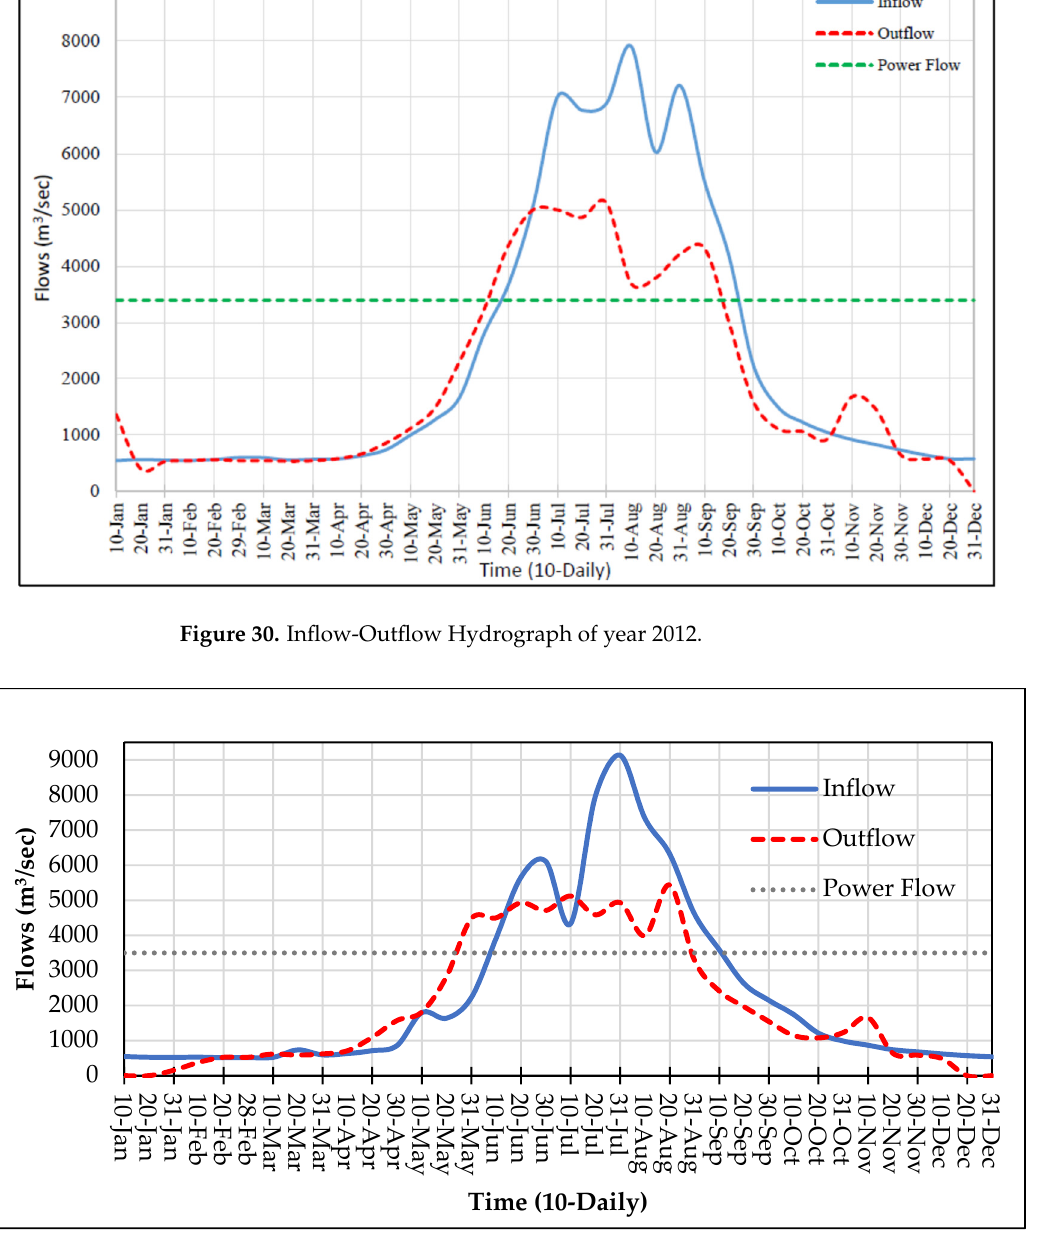
Figure 31. Inflow-Outflow Hydrograph of year 2013.